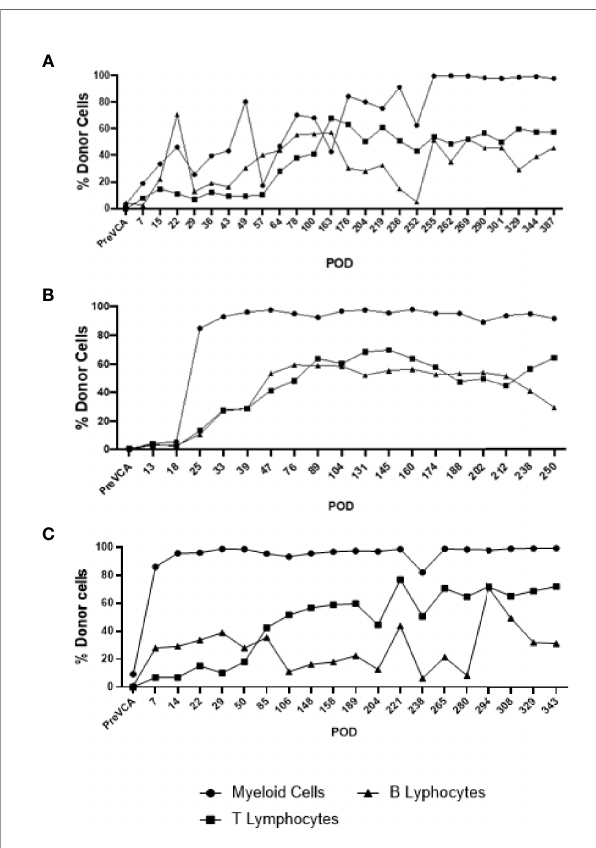
FIGURE 3 | Long-term multi-lineage mixed chimerism in recipient animals R4 (A) , R3 (B) and R5 (C) . Levels of donor chimerism in myeloid cells were >80%, whereas B and T cell populations ranged between 30 to